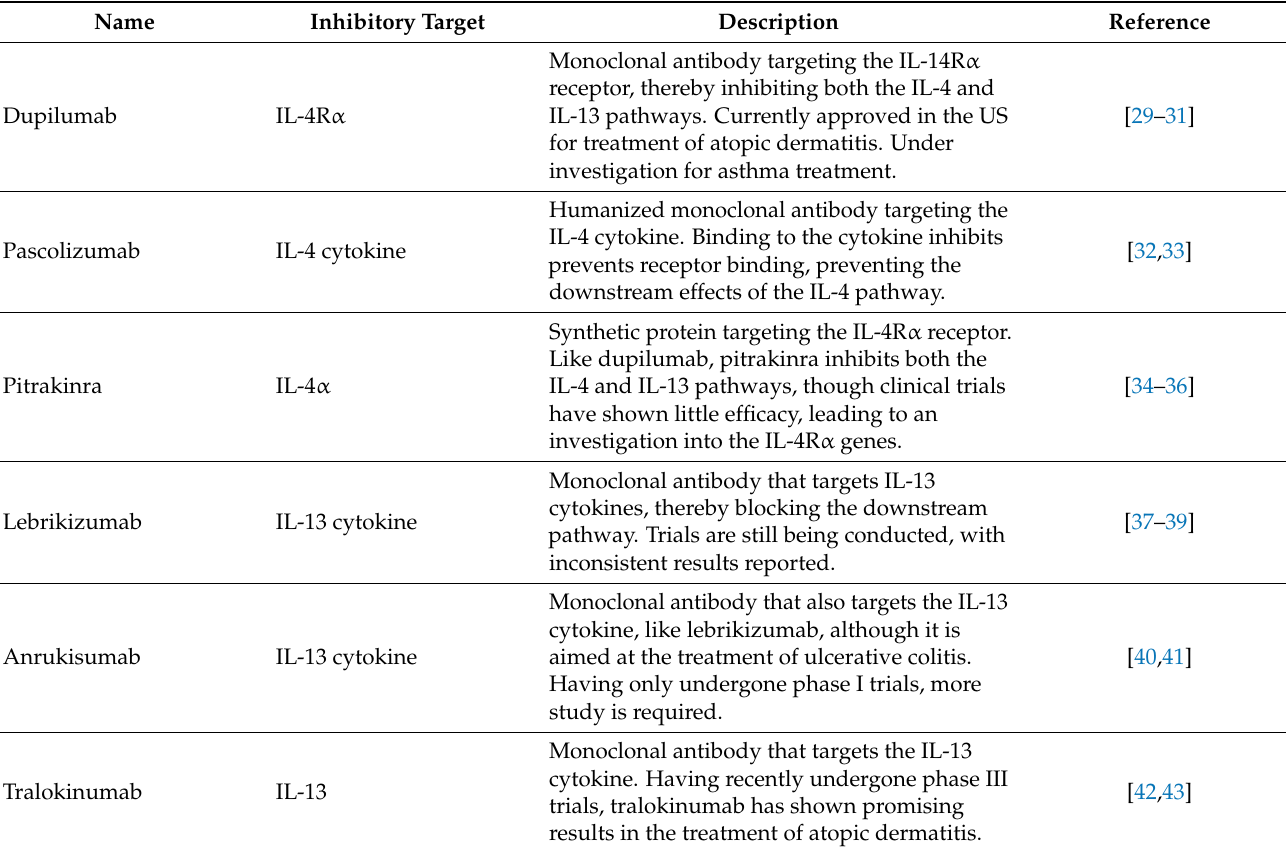
Table 1. Summary of IL-4 and IL-13 inhibitory drugs currently undergoing or that have undergone clinical